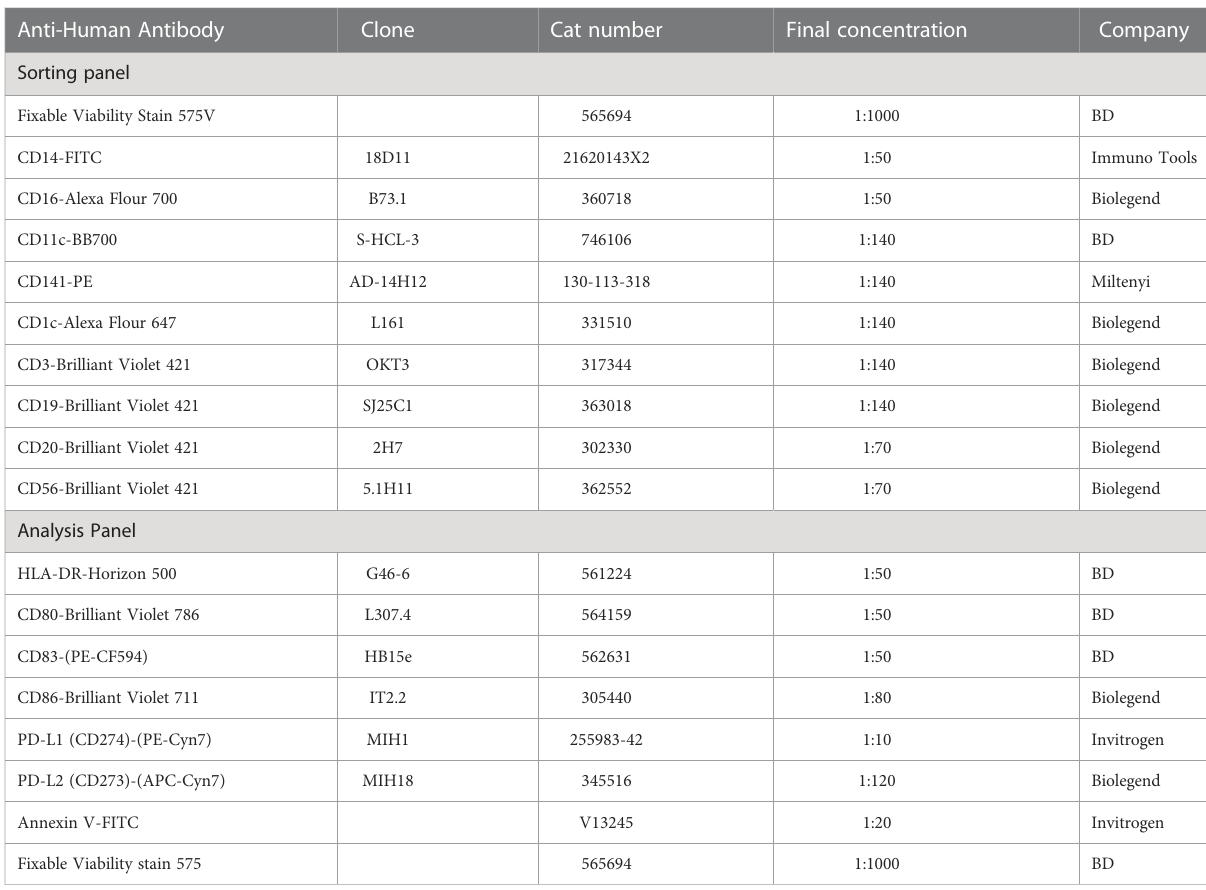
TABLE 1 List of used antibodies for sorting and analyzing of Dendritic cell. Anti-Human Antibody Clone Cat number Final concentration